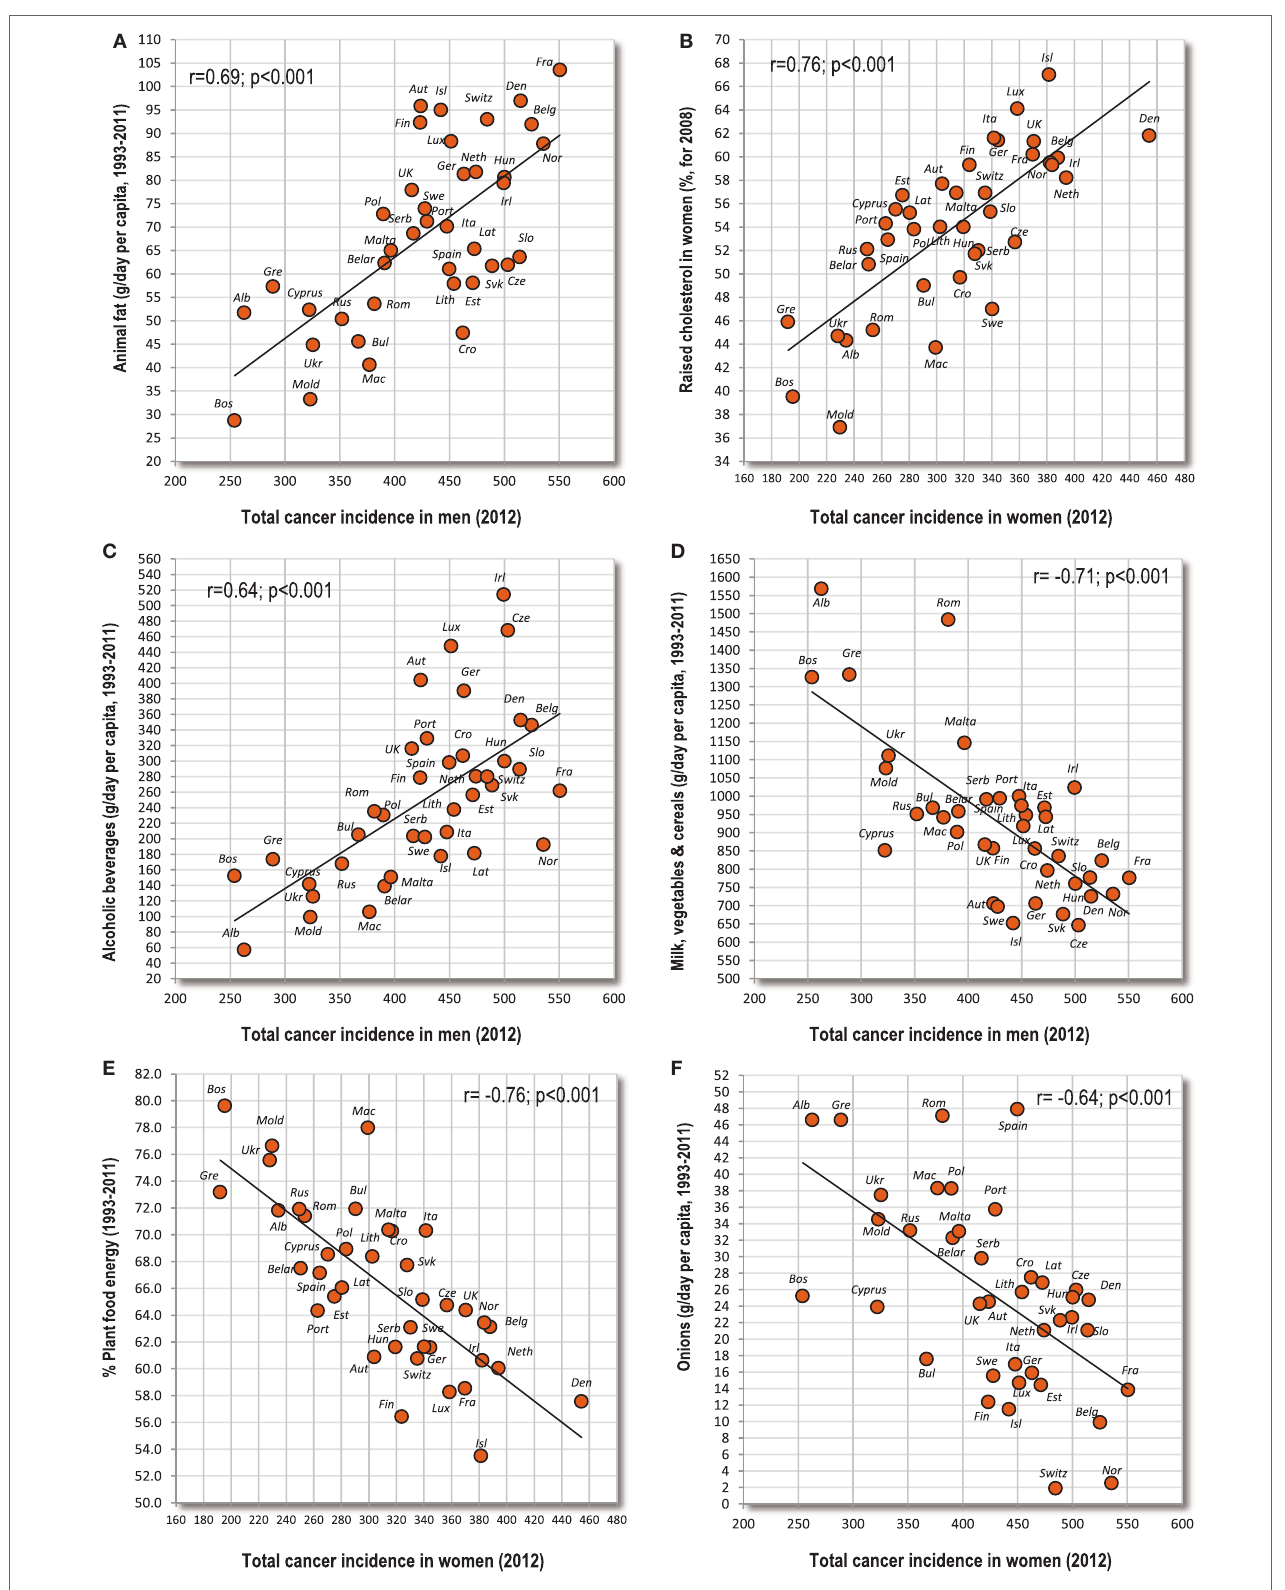
FigUre 6 | (a–F) Relationship between major independent variables and total cancer incidence